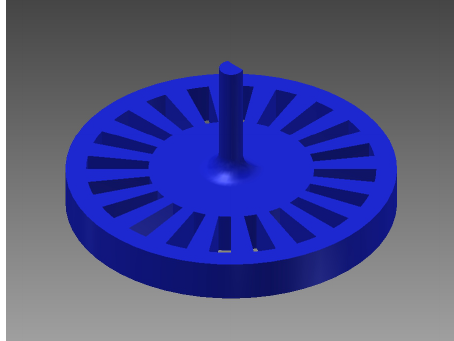
Figure 3. Encoder Wheel and Motor Shaft